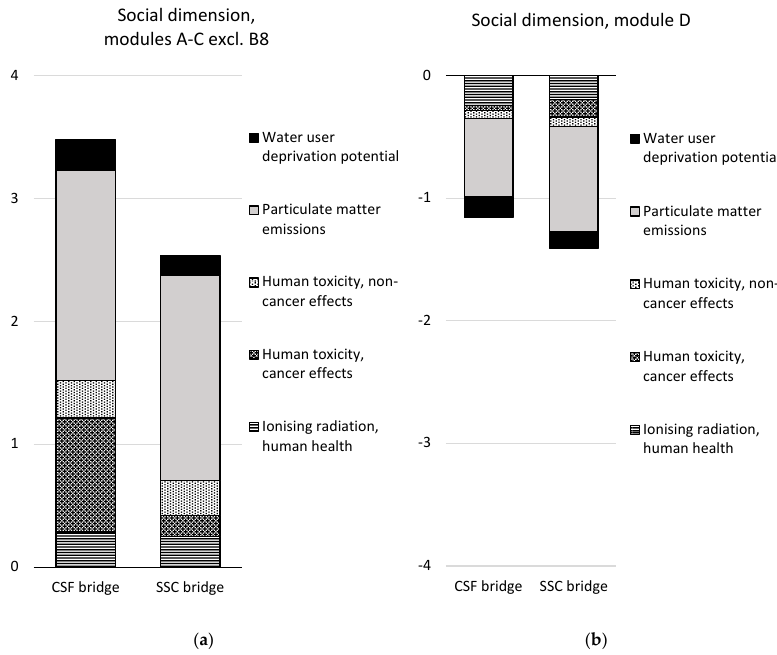
Figure 8. Comparison of the design concepts in the social dimension for ( a ) life cycle stages A–C excluding module B8 and ( b ) module D per indicator and for the functional unit.